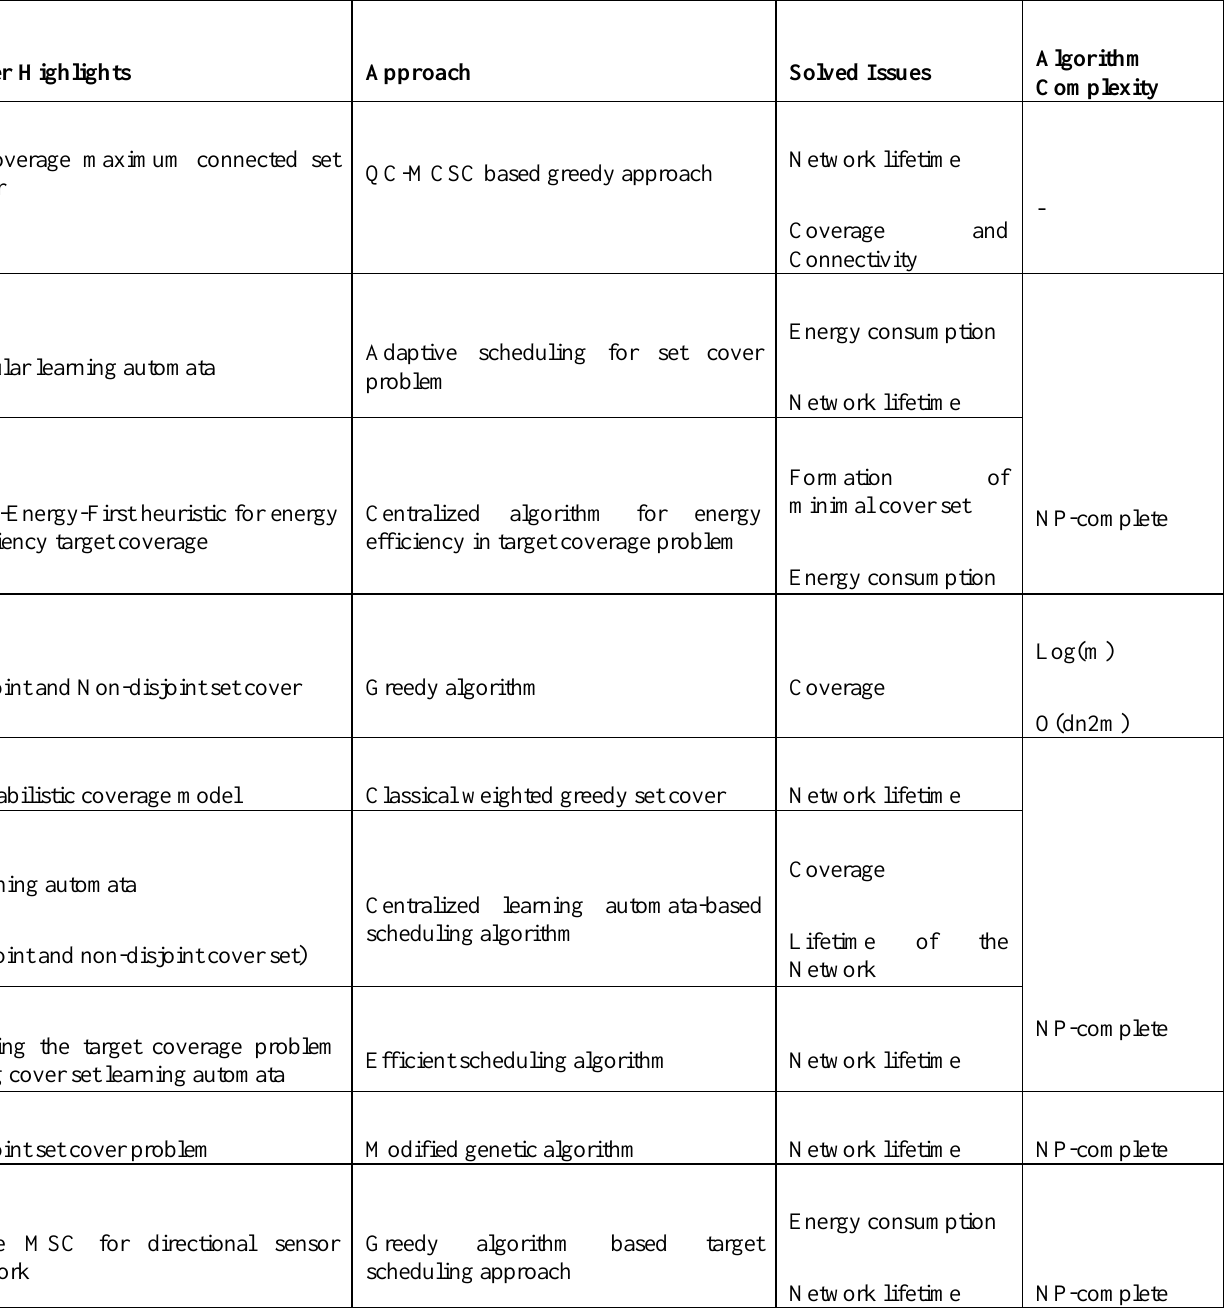
Table 3. Comparative analysis of Set cover